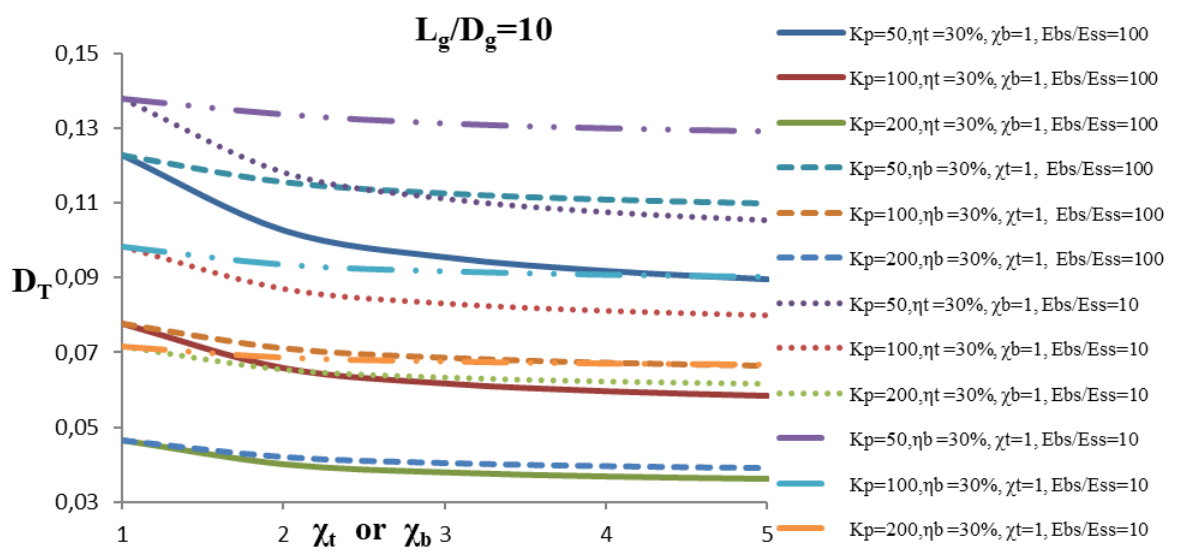
, with strengthening factor for the top, χ T ; PLST of GP, η ; PLSB of GP, η p t /D =10, η or η g g t b